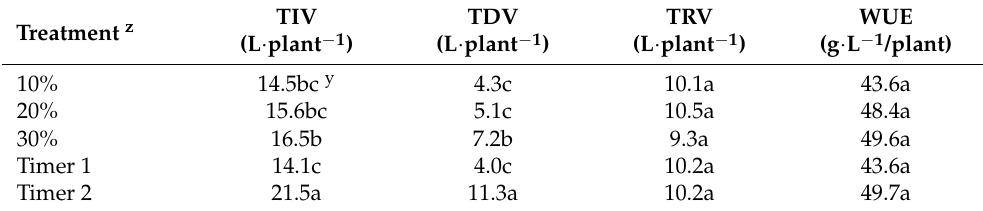
Table 4. Total irrigation volume (TIV), total drainage volume (TDV), total retained volume (TRV), and water use efficiency (WUE) per strawberry ‘Kuemsil’ plants affected by the nutrient solution supplying system using different drainage rate levels and